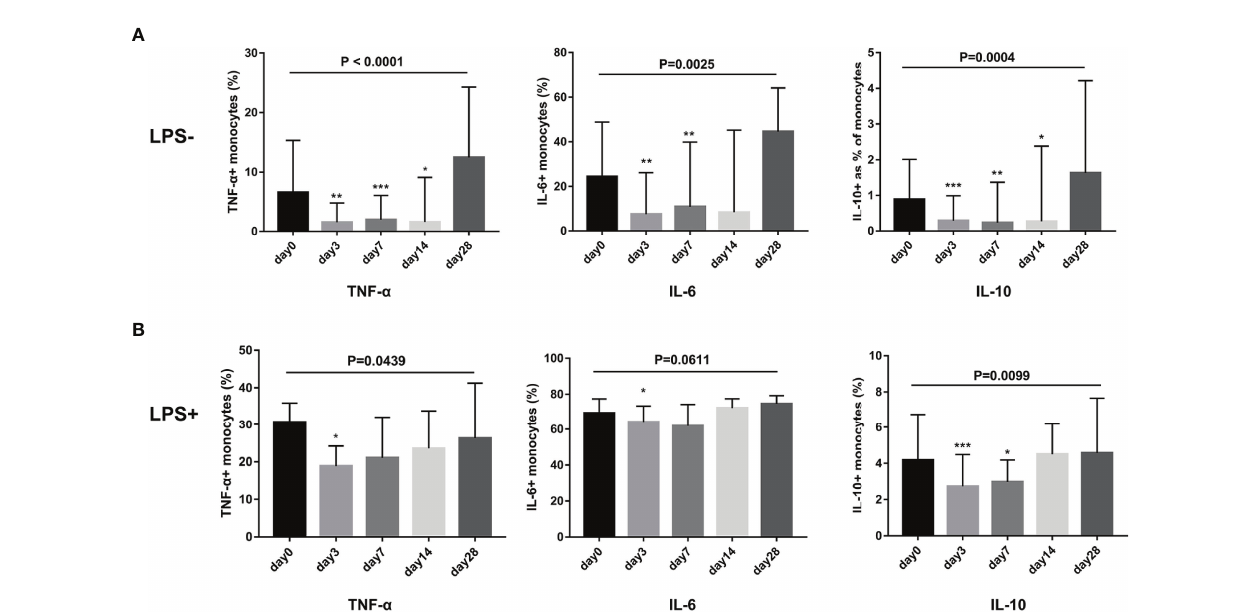
FIGURE 5 | G-CSF therapy attenuated cytokine secretion in monocytes with or without LPS stimulation in HBV-ACLF patients (n=12). (A) Cytokine secretion in monocytes without LPS stimulation. (B) Cytokine secretion in monocytes with LPS stimulation. Non-parametric (Wilcoxon ’ s matched-pair test) statistical analysis was used. Data presented as median with interquartile range. Compared with day 0, * P < 0.05, ** P < 0.01, *** P < 0.001. G-CSF, Granulocyte-colony stimulating factor; HBV-ACLF, hepatitis B virus-related acute-on-chronic liver failure; LPS,